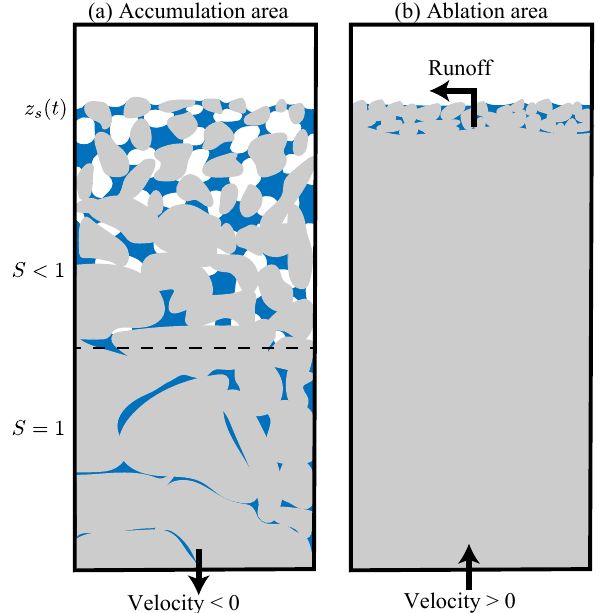
Figure 1. The three components of meltwater-infiltrated snow: air, water, and ice. Panel (a) shows water infiltrating an accumulation area where the snow density increases with depth and snow ad- vects down. The water partially saturates the snow near the surface ( S < 1) whereas, at depth, all of the air is replaced by water and the snow is fully saturated ( S = 1). Panel (b) shows an ablation area where the there is fully saturated porous snow in a thin layer near the surface and the underlying ice is solid, advecting into the do- main from upstream. Ice grains make contact in the third dimension (into the page) and similarly many of the air and water pockets are connected in the third